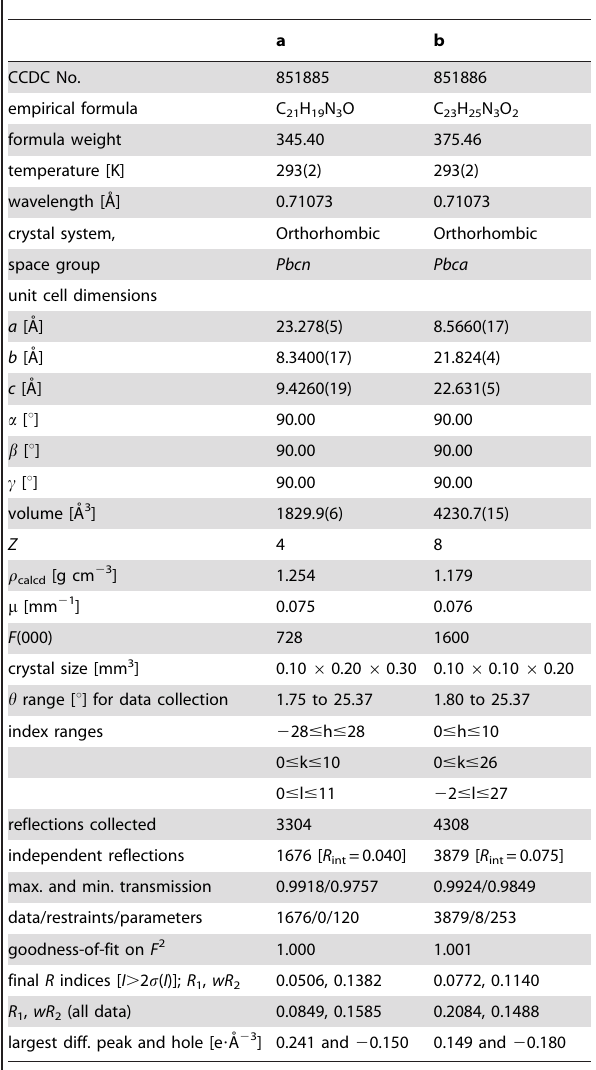
Table 1. Crystal data and structure refinement for a and